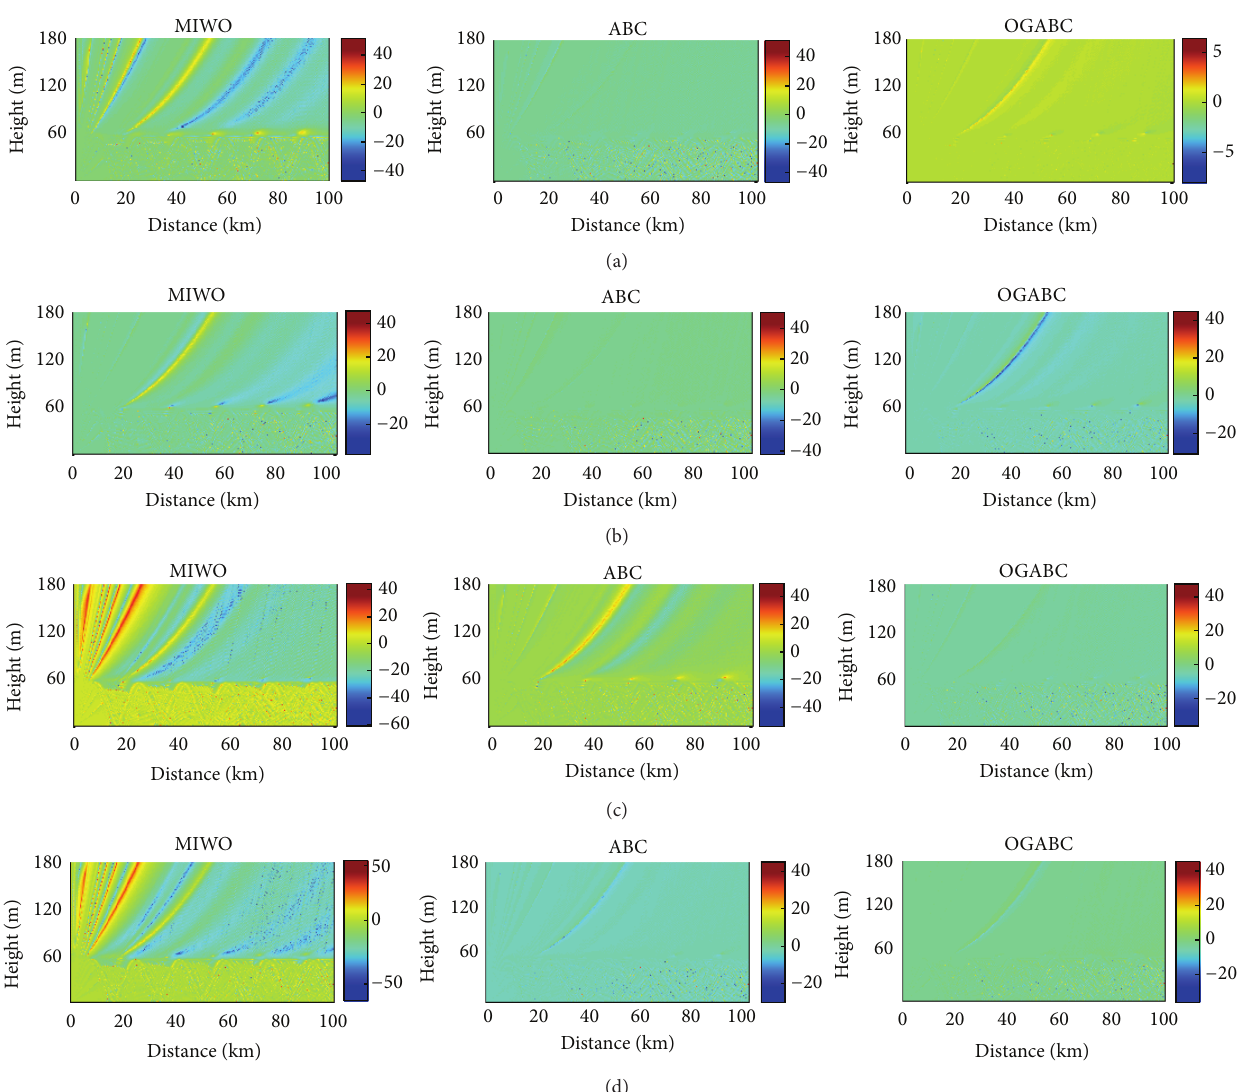
Figure 7: The comparison of the difference between the inverted and actual coverage diagram with different noise level: (a) 0dB; (b) 1dB; (c) 2 dB; and (d) 3 dB.